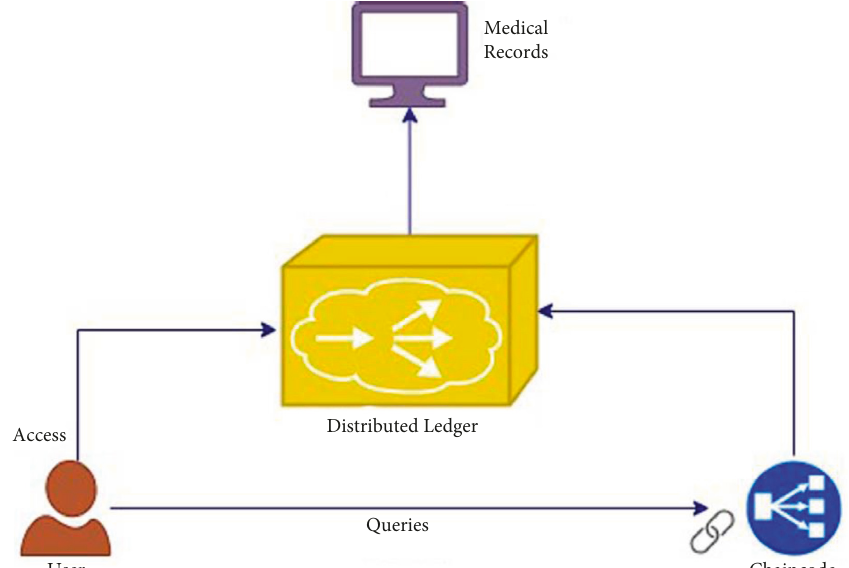
Figure 5: Client-server-based EHR.